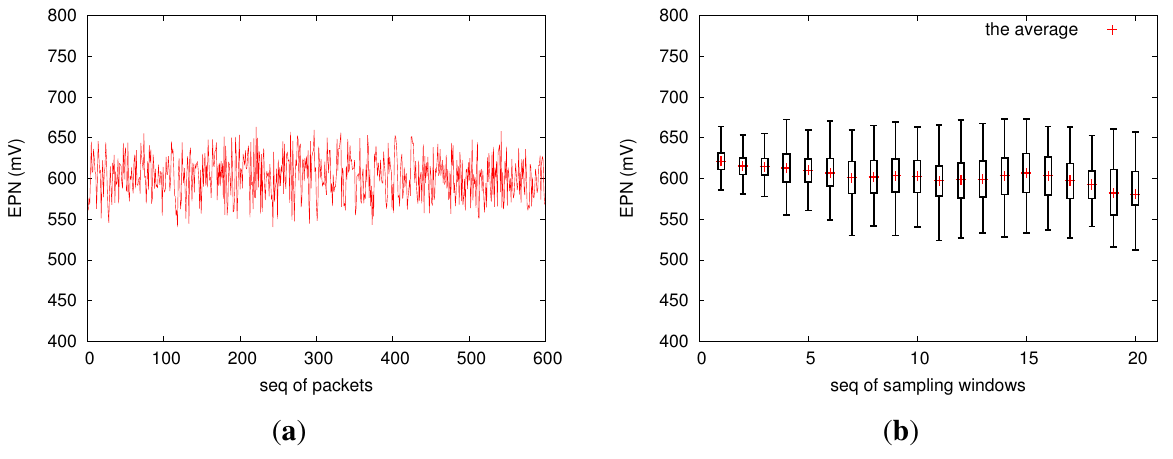
Figure 10. The electrochemical potential noise (EPN) distribution over sampling windows where ( a ) plots the EPN variation during the 10th sampling window; and ( b ) profiles the statistics for each of the 20 consecutive sampling